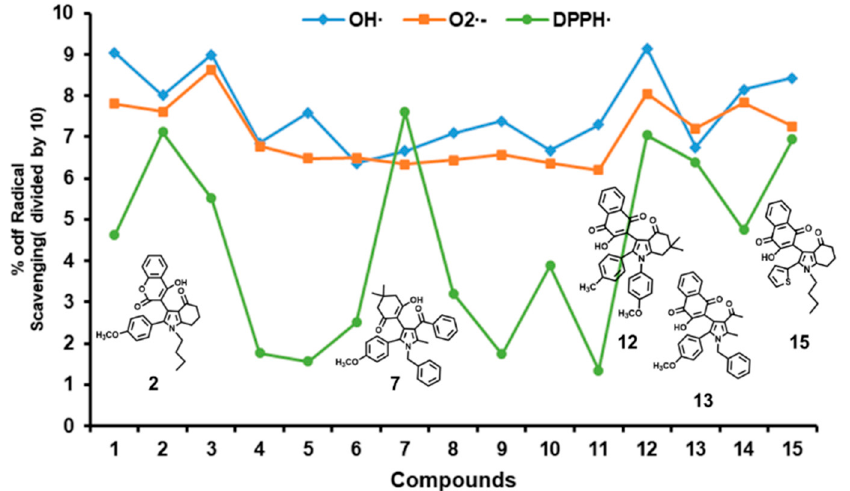
Figure 1. Fifteen pyrrole derivatives with their • OH, O 2 •− , and DPPH • activities, expressed as (percent scavenging activity)/10, (data collected from reported work [30]), were used as the training set in the QSAR study.